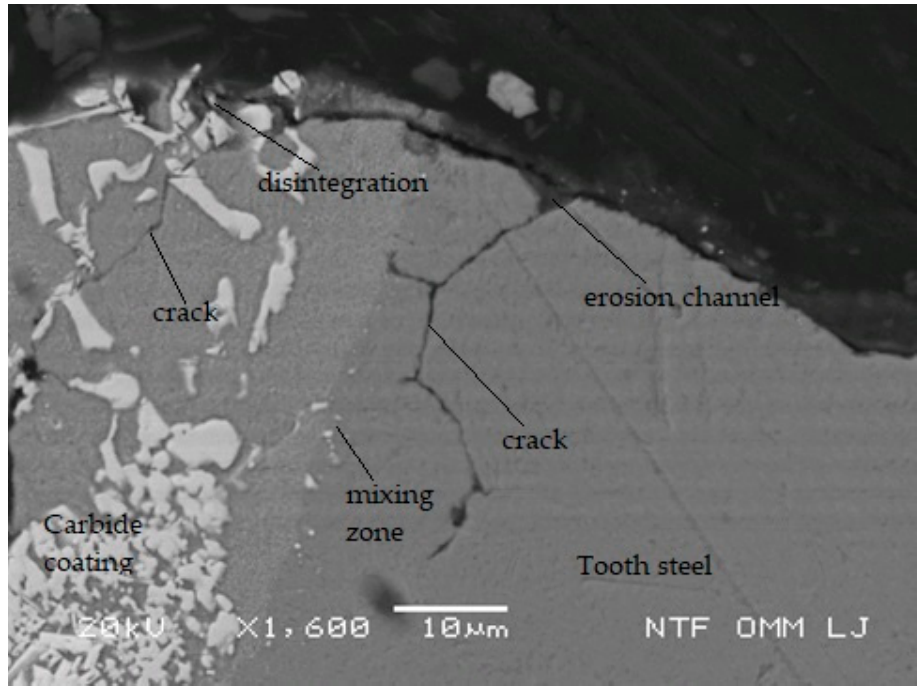
Figure 11. Formation of microcracks due to different elastic properties of materials.